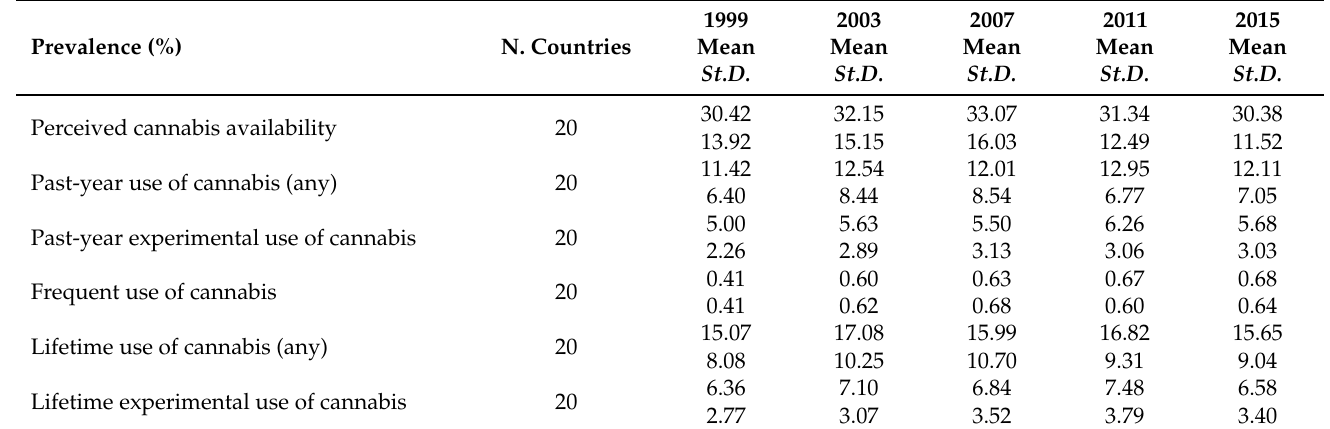
Table 3. Descriptive statistics of outcome variables.